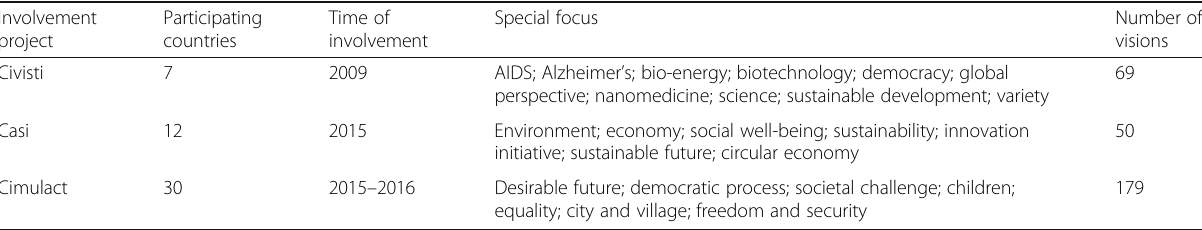
Table 1 Characteristics of the examined citizen involvement projects Involvement project